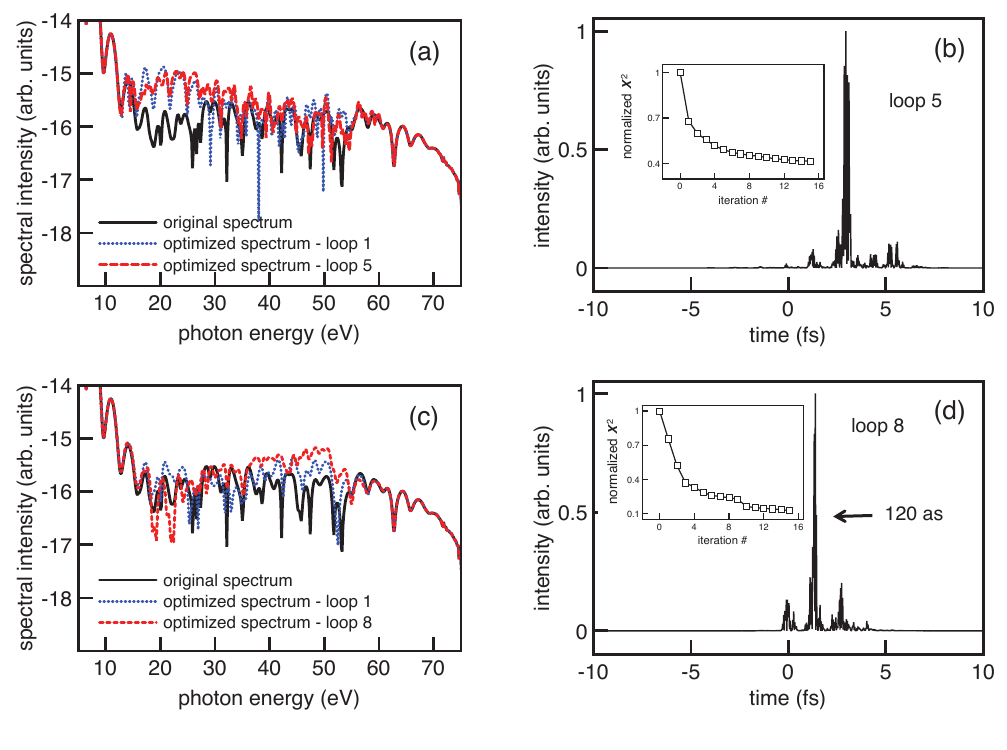
Figure 6. (Color online) Optimization of the HHG spectral region 21–51 eV obtained by considering several iterations of the feedback loop for (cid:11) scanned from (cid:11) = 10 9 to (cid:11) = 10 10 ( a , b ) and from (cid:11) = 10 11 to (cid:11) = 10 12 ( c , d ). ( a , b ): The scan in the first iteration in (cid:18) is from (cid:18) = − 720 ◦ to (cid:18) = 720 ◦ . In the subsequent iterations, (cid:18) is scanned from (cid:18) = 200 ◦ to (cid:18) = 700 ◦ . In ( a ) the spectral intensity of the original and optimized spectra are shown for the first and 5 th iterations, as indicated. The optimal values of the fitness parameters for the 5 th iteration are in this case (cid:11) = 10 10 and (cid:18) = 496 ◦ . In ( b ) the temporal evolution of the intensity of the XUV pulse resulting from the second interaction region after the 5 th iteration (loop) is shown. The inset in ( b ) shows the value of the normalized (cid:31) 2 parameter as a function of the iteration number. From approximately the 5 th iteration the value of (cid:31) 2 and the intensity profile of the resulting XUV pulse do not change substantially. ( c ) and ( d ): The scan in the all the iterations in (cid:18) is from (cid:18) = − 720 ◦ to (cid:18) = 720 ◦ . In ( c ) the spectral intensity of the original and optimized spectra are shown for the first and 8 th iterations, as indicated. The optimal values of the fitness parameters for the 8 th iteration are in this case (cid:11) = 10 12 and (cid:18) = 365 ◦ . In ( d ) the temporal evolution of the intensity of the XUV pulse resulting from the second interaction region after the 8 th iteration is shown, which is an isolated single cycle pulse centered at 36 eV. The inset in ( d ) shows the value of the normalized (cid:31) 2 parameter as a function of the iteration number. From approximately the 8 th iteration, the duration of the intensity profile of the resulting central XUV pulse does not change substantially. Note that the labels in the vertical axis of ( a ) and ( c ) indicate a logarithmic